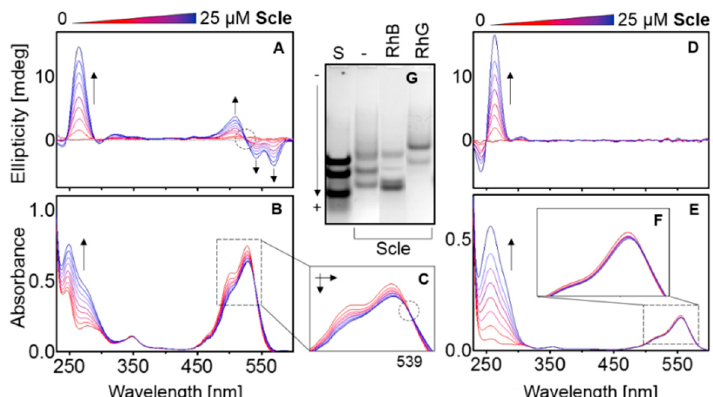
Figure 4. CD and UV-Vis spectra of 130 µ M RhG ( A , B ) and RhB ( D , E ) in mRB, supplemented with 50 mM KCl, pH 7.0. The increment of the Scle oligomer is 3.35 µ M. The final concentration of DNA is ~27 µ M (0.2 ekv). The enlarged UV-Vis region of the RhG absorption spectra shows a clear isosbestic point at 539 nm ( C ), but not in ( F ). 12% PAGE ( G ) in corresponding conditions; the concentration of the ligand in the two columns is 130 µ M. The standard is a mixture of oligonucleotides AC9, AC18 and AC28.